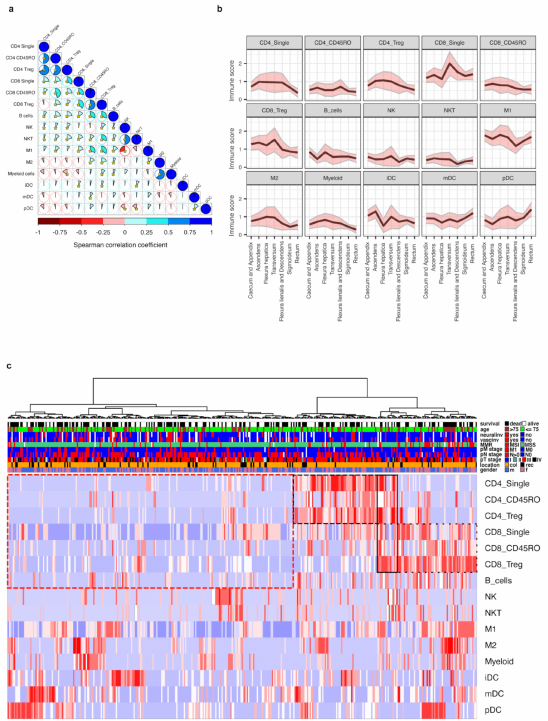
Figure 2. The immune scores interrelations, distribution across different clinical and pathological groups and unsupervised hierarchical clustering. ( a ) Graphical representation of Spearman’s correla- tion matrix between immune scores. Pie charts and the intensity of shading represent the strength of correlation (Spearman correlation coefficient), blue color indicates direct while red color indicates inverse correlation. Asterisks indicate statistical significance ( p < 0.05). ( b ) Immune scores mean levels (black line) and 95% confidence intervals (pink areas limited by gray lines) at specific primary tumor locations. For additional data, see Table S2. ( c ) Unsupervised hierarchical cluster analysis of immune scores. Cases were clustered based on the levels of immune scores. A total of 373 cases with complete immune score data from therapy-naïve patients were available. Clusters with enriched CD4 or CD8 cells are marked by dashed black line, while the cluster with low lymphocyte level is marked by dashed red line. For additional data, see Table